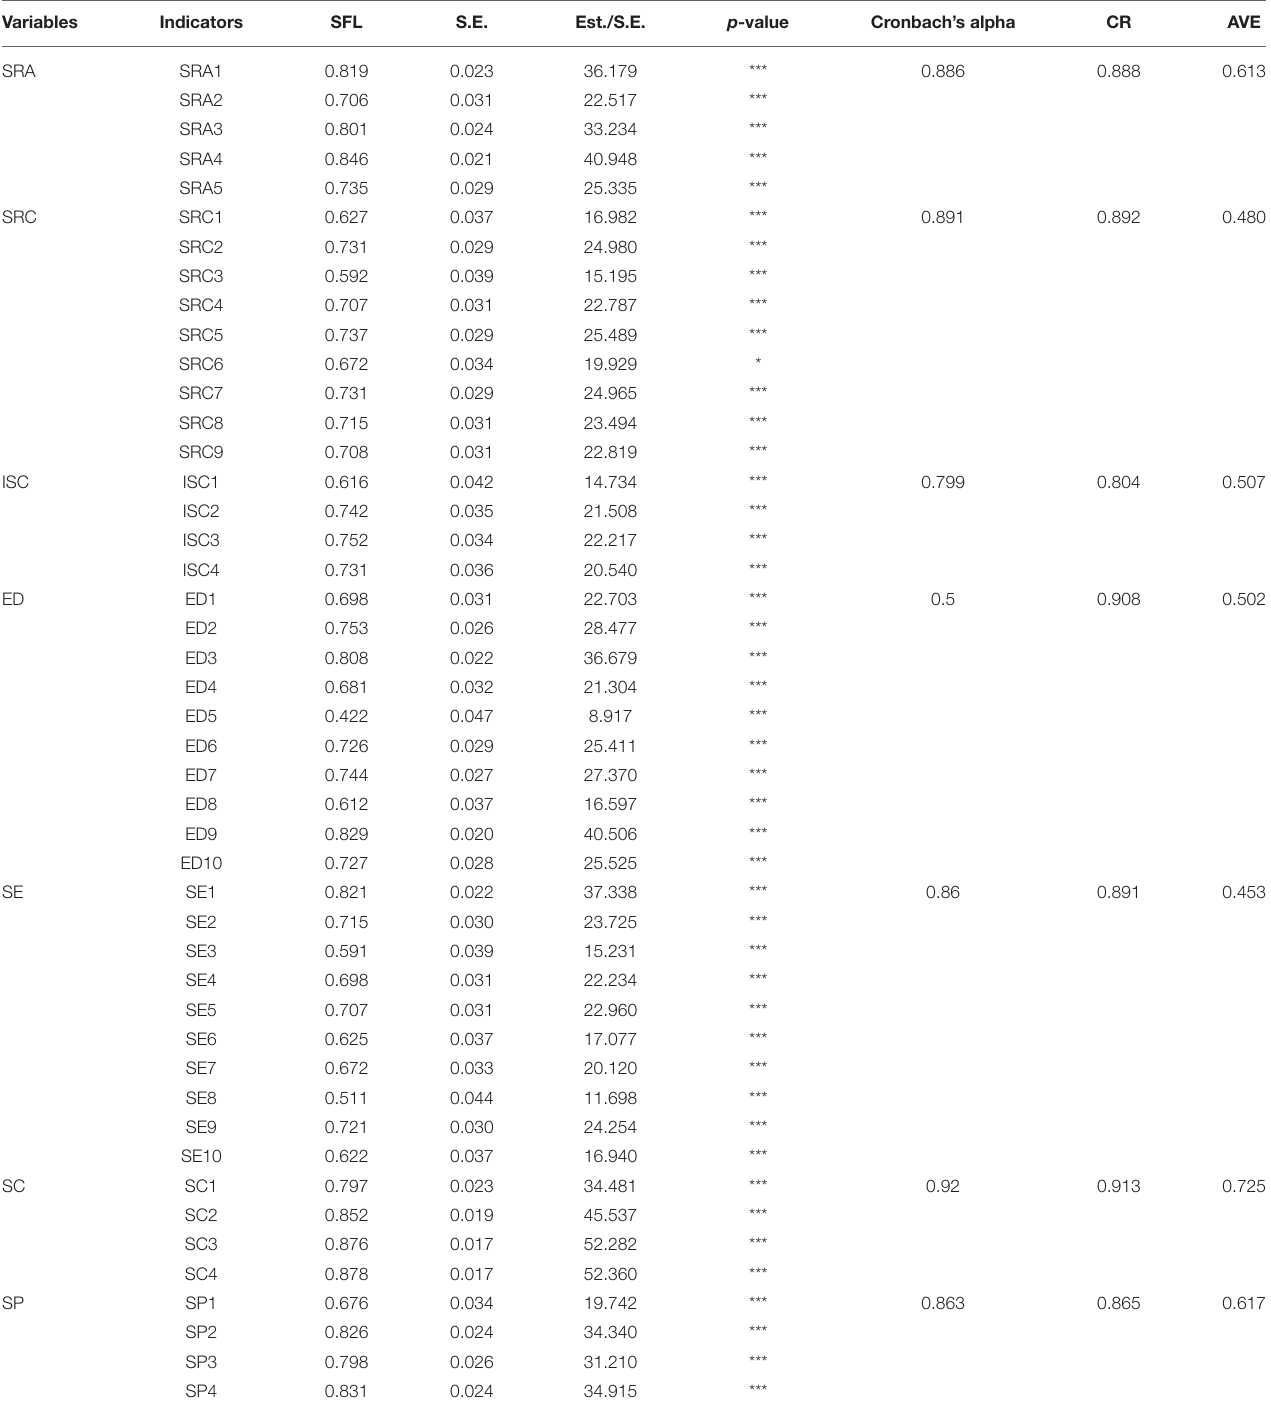
TABLE 3 | Results of reliability and validity testing.